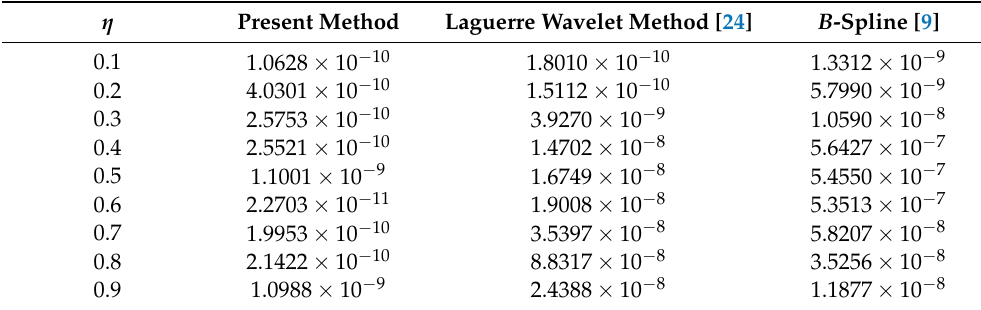
Figure 6. ( a ) Absolute error at k = 2, M = 3; ( b ) absolute error at k = 4, M = 5 of Example 2. Table 4. Comparison of the proposed method’s absolute error with the HWM and B -spline methods of Example 2 for ζ = 0.1.